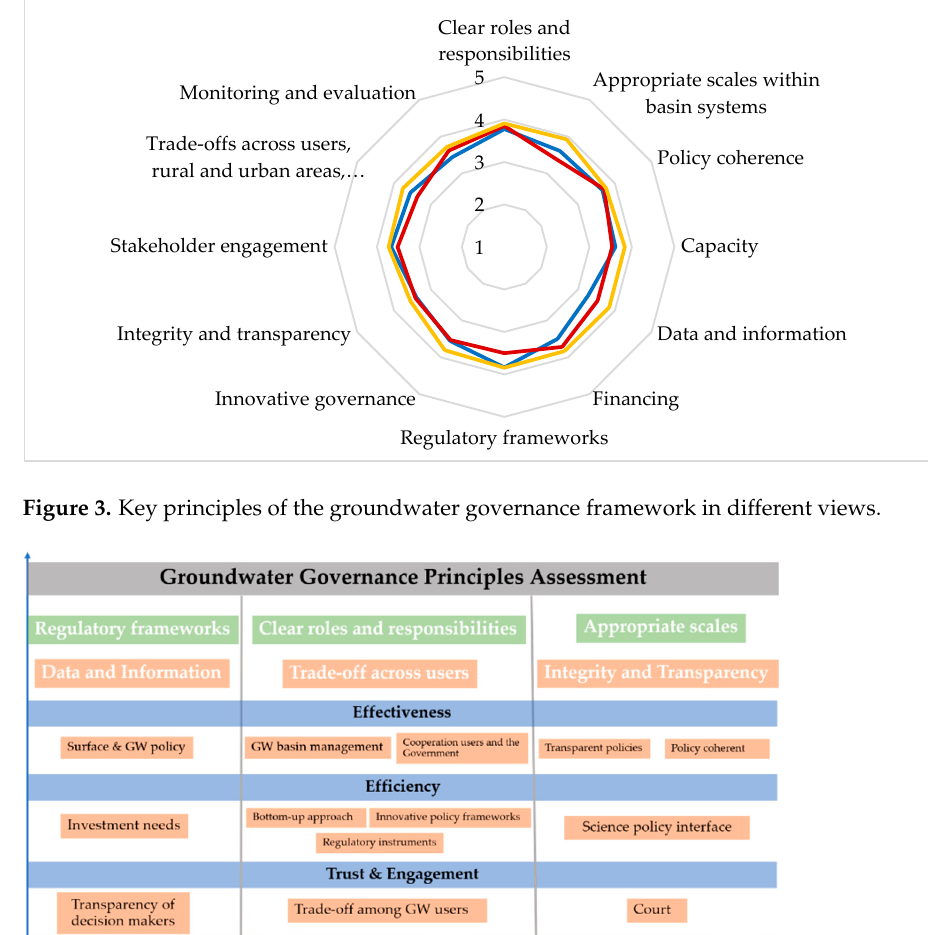
Figure 4. Groundwater Governance Principles Assessment.